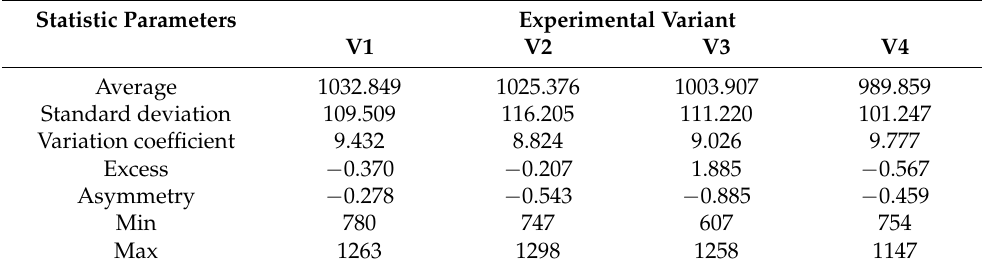
Table 5. General statistical parameters (average, standard deviation, variation coefficient—%, asym- metry, excess, minimum and maximum) for sound speed (m · s − 1